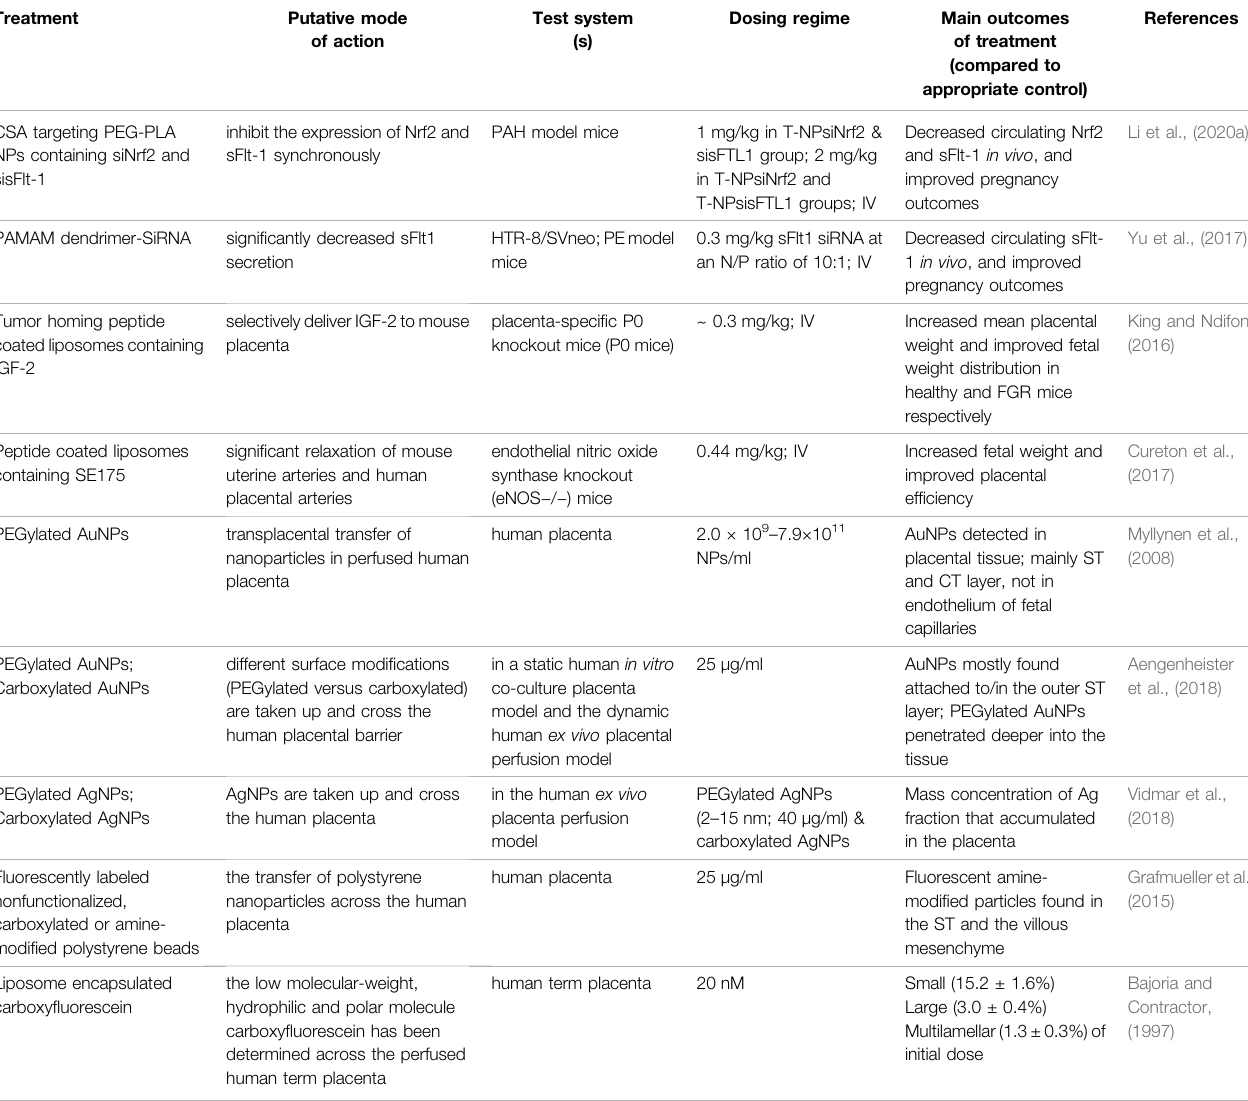
TABLE 3 | Targeted drug delivery systems and human ex vivo placenta perfusion model to investigate placenta-NP